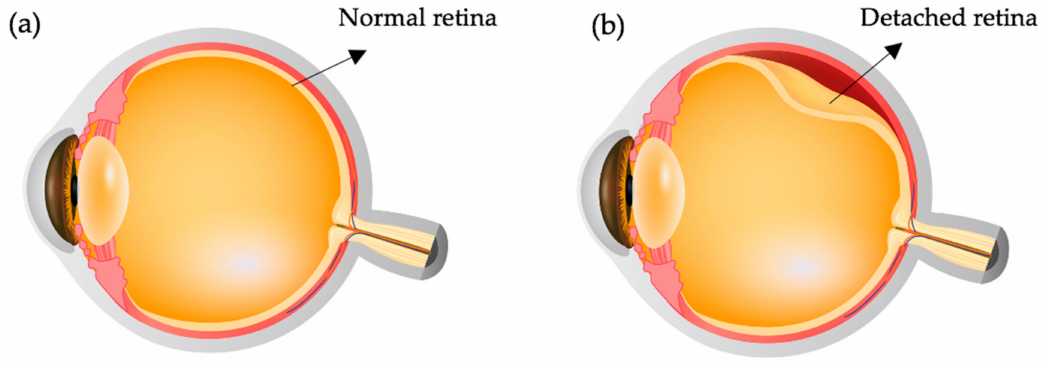
Figure 2. ( a ) Healthy eye ( b ) Retinal